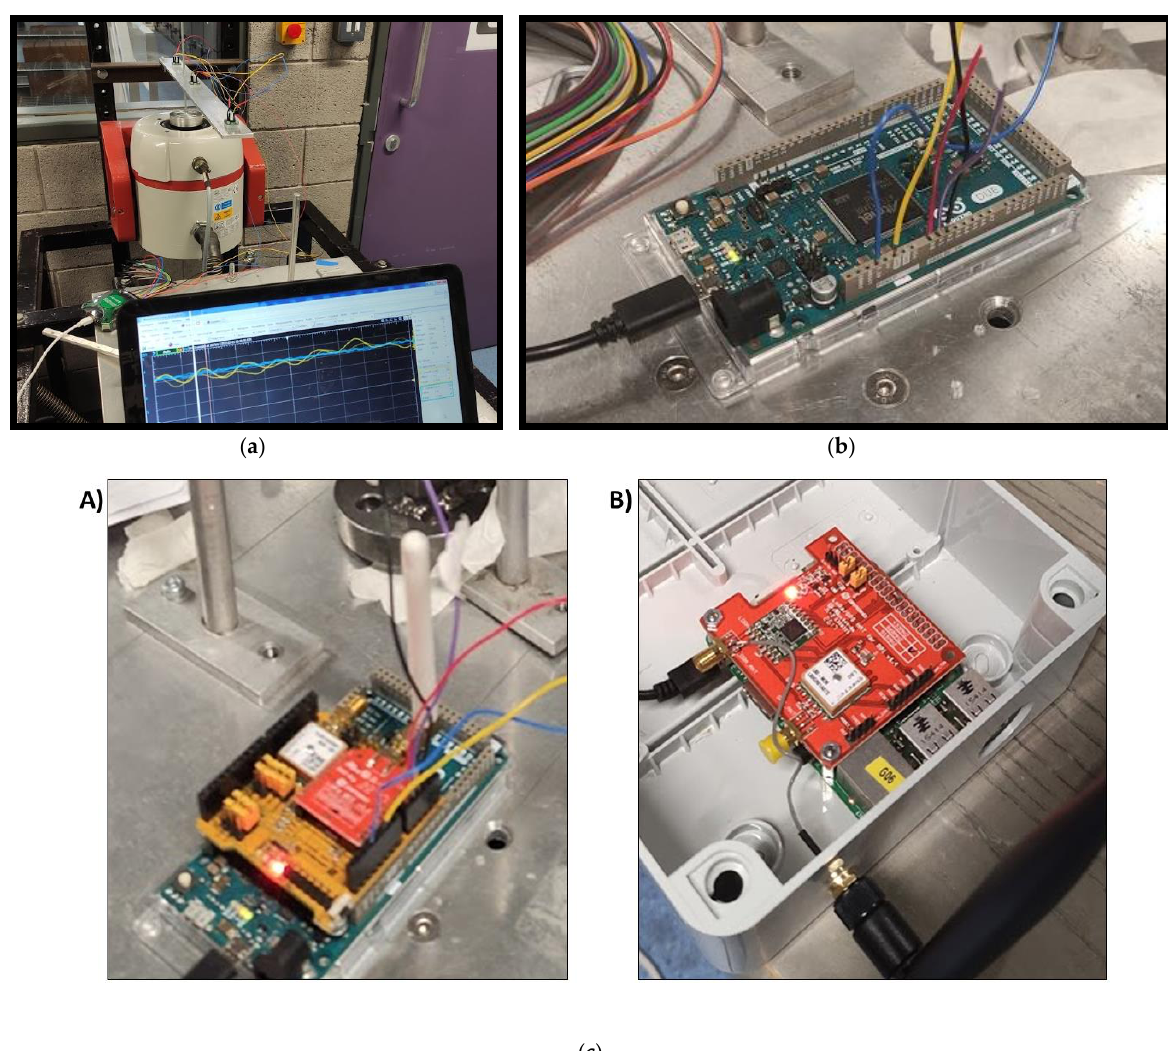
Figure 6. ( a ): Oscilloscope Realtime display from accelerometers; ( b ): Arduino connected via analog inputs to accelerom- eters; ( c ): LoRa transmission via ( A ) edge device, Arduino microcontroller with LoRa shield; ( B ) gateway, raspberry Pi microprocessor with LoRa receiver hat.